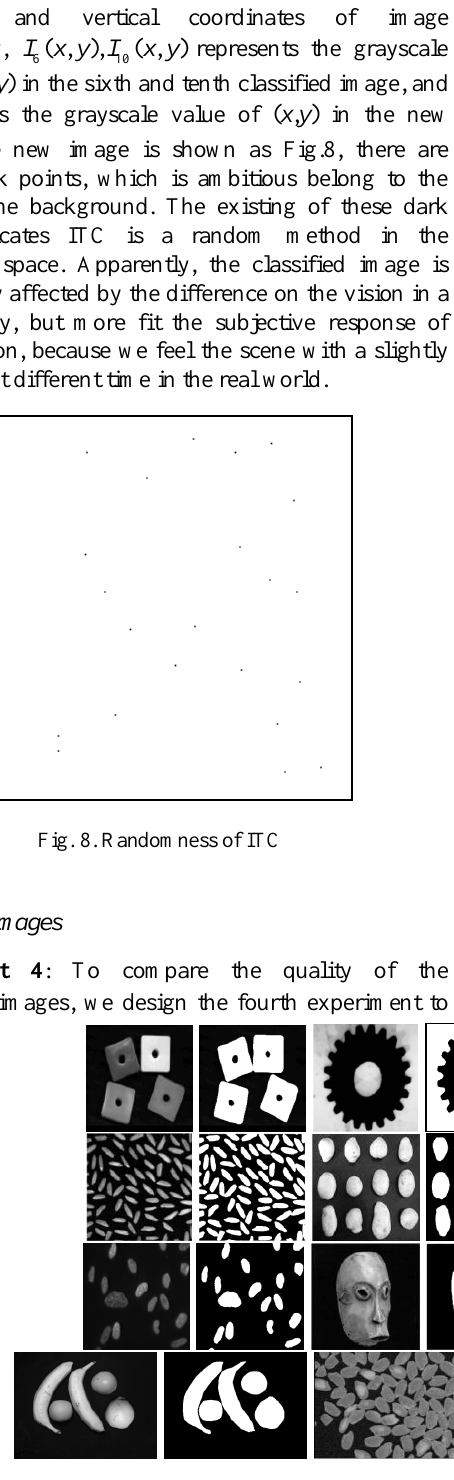
Fig. 9. Test images and the corresponding ground-truth